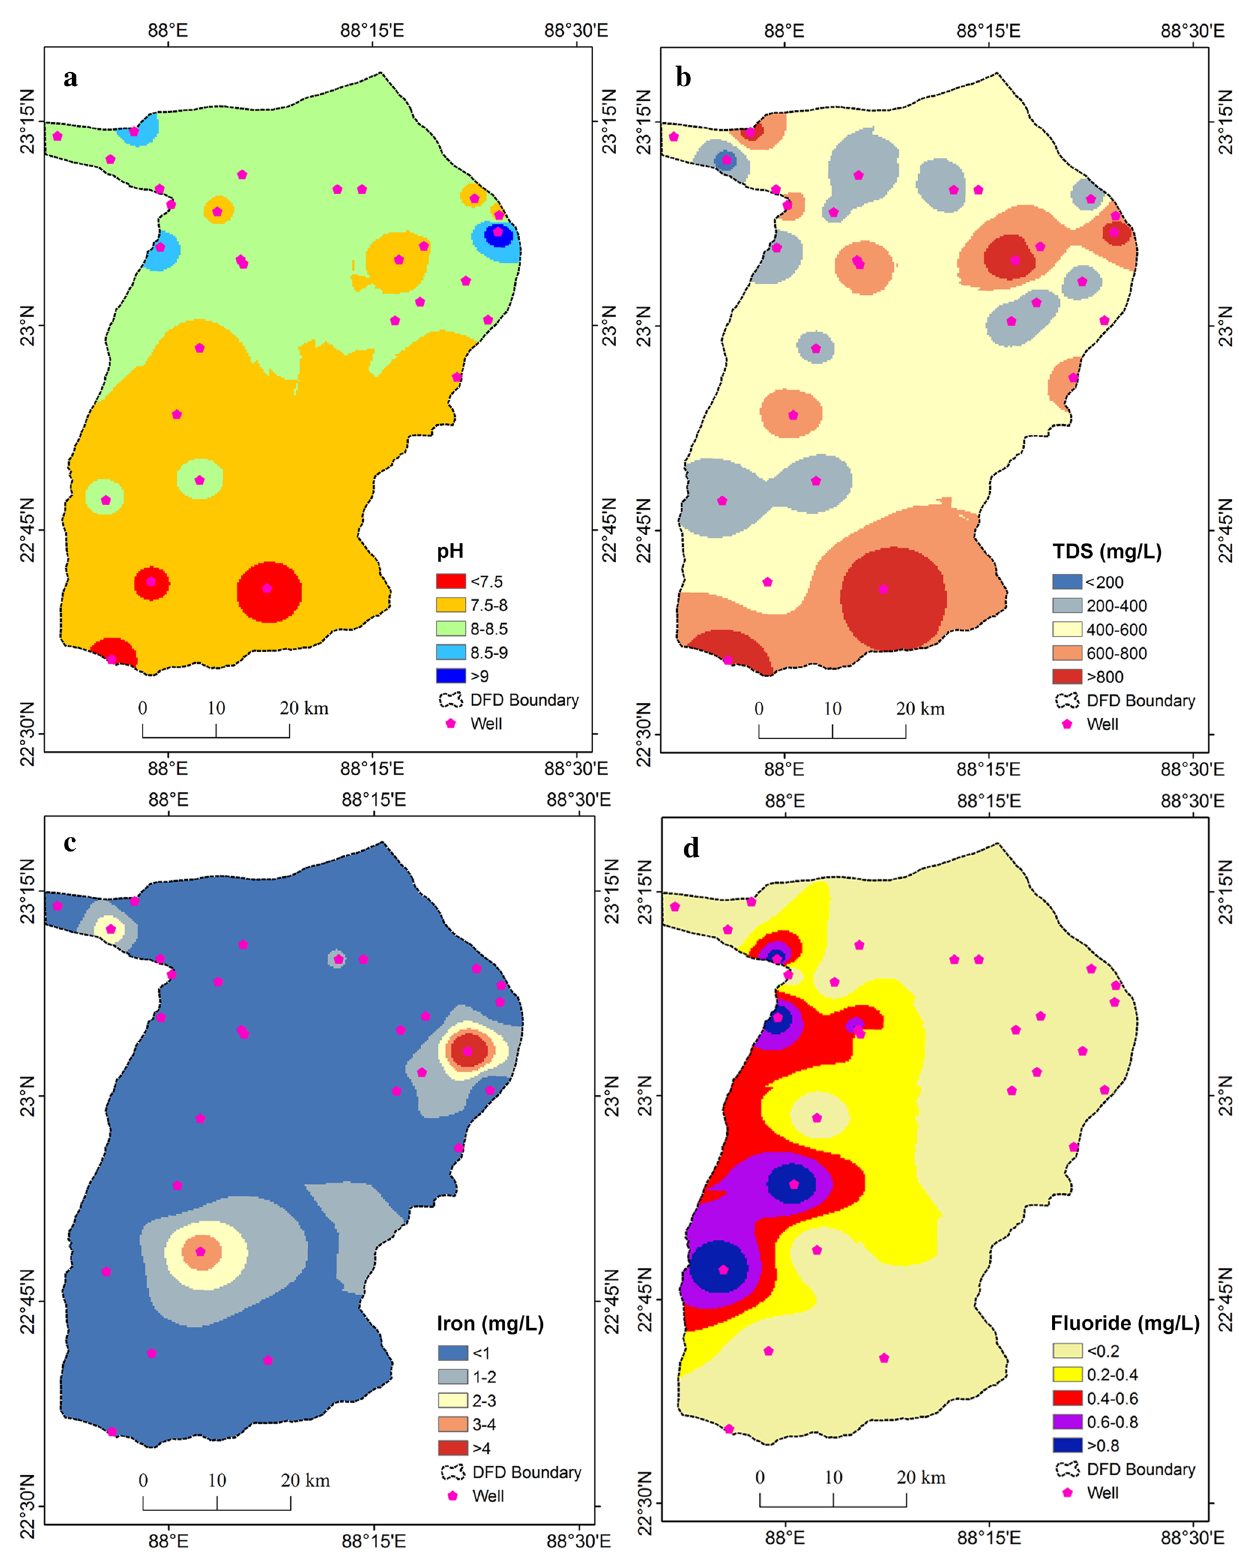
Fig. 5 Spatial distribution of groundwater quality parameters a pH, b TDS, c Iron, and d